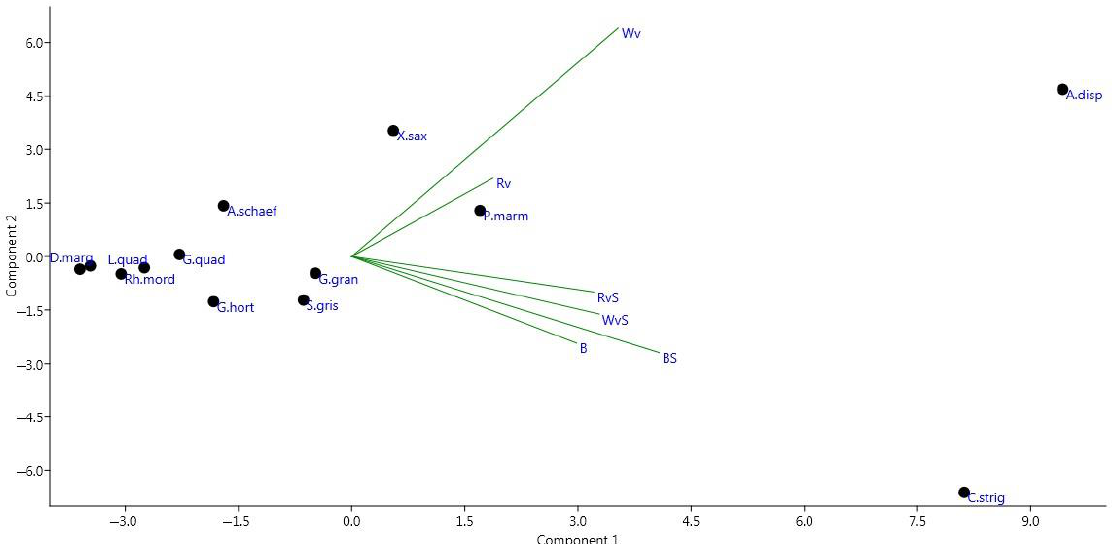
Figure 5. Canonical analysis of the number of recorded specimens of various species, depending on the composition of the bait (see the caption to Figure 4). Species: A.schaef— Attagenus schaefferi (Dermestidae), P.marm— Protaetia marmorata (Scarabaeidae), D.marg— Dalopius marginatus (Elateridae), C.strig— Cryptarcha strigata (Nitidulidae), G.hort— Glischrochilus hortensis (Nitidulidae), G.quad— Glischrochilus quadripunctatus (Nitidulidae), G.gran— Glischrochilus grandis (Nitidulidae), S.gris— Soronia grisea (Nitidulidae), L.thor— Leptura thoracica (Cerambycidae), L.quad— Leptura quadrifasciata (Cerambyci- dae), Rh.mord— Rhagium mordax (Cerambycidae), A.disp— Anisandrus dispar (Curculionidae), X.sax— Xyleborus saxesenii